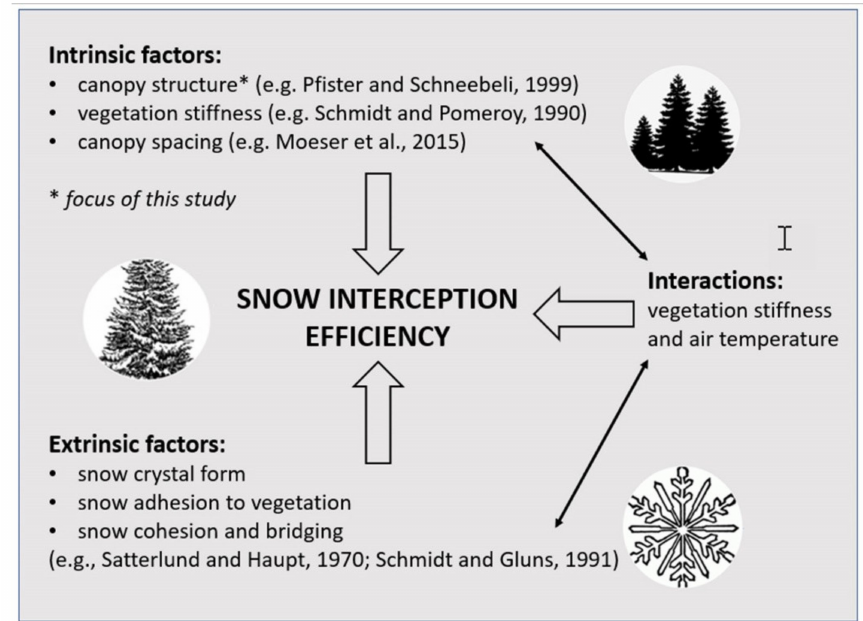
Figure 1. Factors controlling snow interception